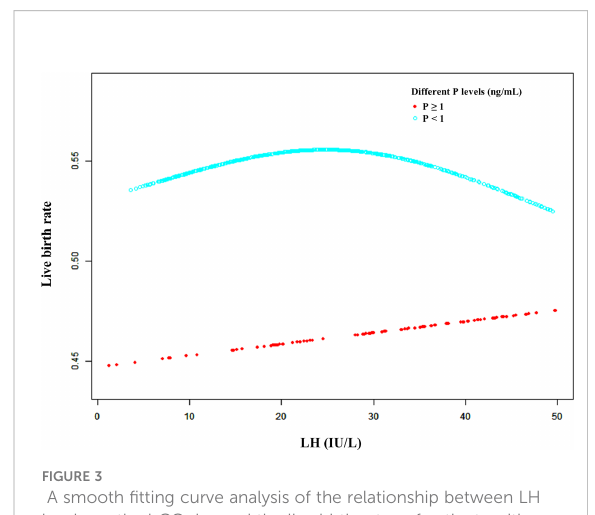
FIGURE 3 A smooth fi tting curve analysis of the relationship between LH levels on the hCG day and the live birth rates of patients with different P levels. The live birth rate decreased as the LH level on the hCG day gradually increased when the P level was equal to or greater than 1 ng/mL. In addition, the live birth rate of the patients with a lower P level (less than 1 ng/mL) on the hCG day decreased as the LH level gradually increased when the LH level was beyond a certain value.